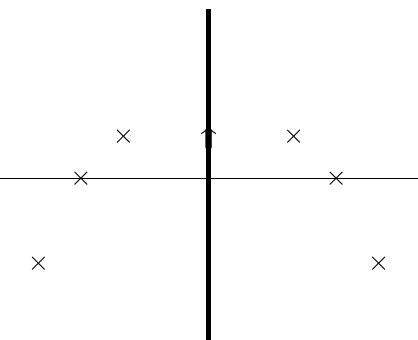
Figure 1 . Distribution of poles in a complex loop energy plane for vanishing external momenta. The poles are situated symmetrically about the imaginary axis. The vertical positions of the poles are determined by the values of purely imaginary loop energies along other loops, and the horizontal positions are determined by the spatial components of all loop momenta and masses which are all real. The loop energy integration contour is taken to be from (cid:0) i 1 to i 1 along the imaginary axis as shown by the thick vertical line. As we deform the external momenta away from zero the pole positions move, and if any pole approaches the integration contour we have to deform the integration contour to avoid the